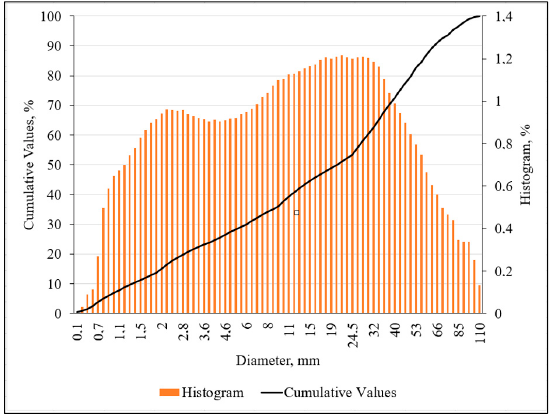
Figure 2. The particles’ size distribution of raw clay.